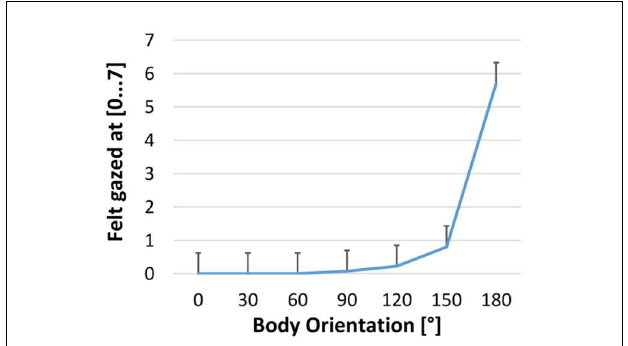
FIGURE 7 | Impression of being gazed at for avatars in different body orienations from not at all (0) to maximally (7).